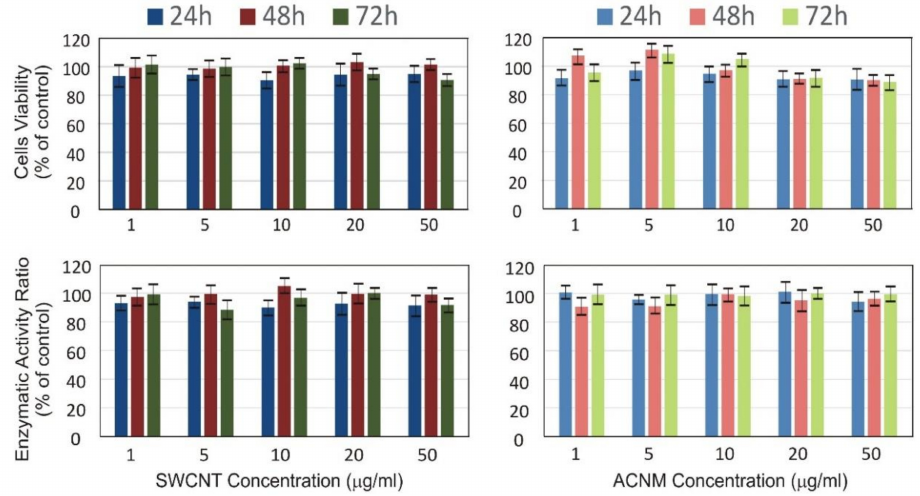
Figure 3. ( top ) Cell viability and ( bottom ) membrane damage of mesenchymal stem cells exposed to ( left ) SWCNT and ( right ) ACNM in short-term evaluation. Bars represent mean ± SD.